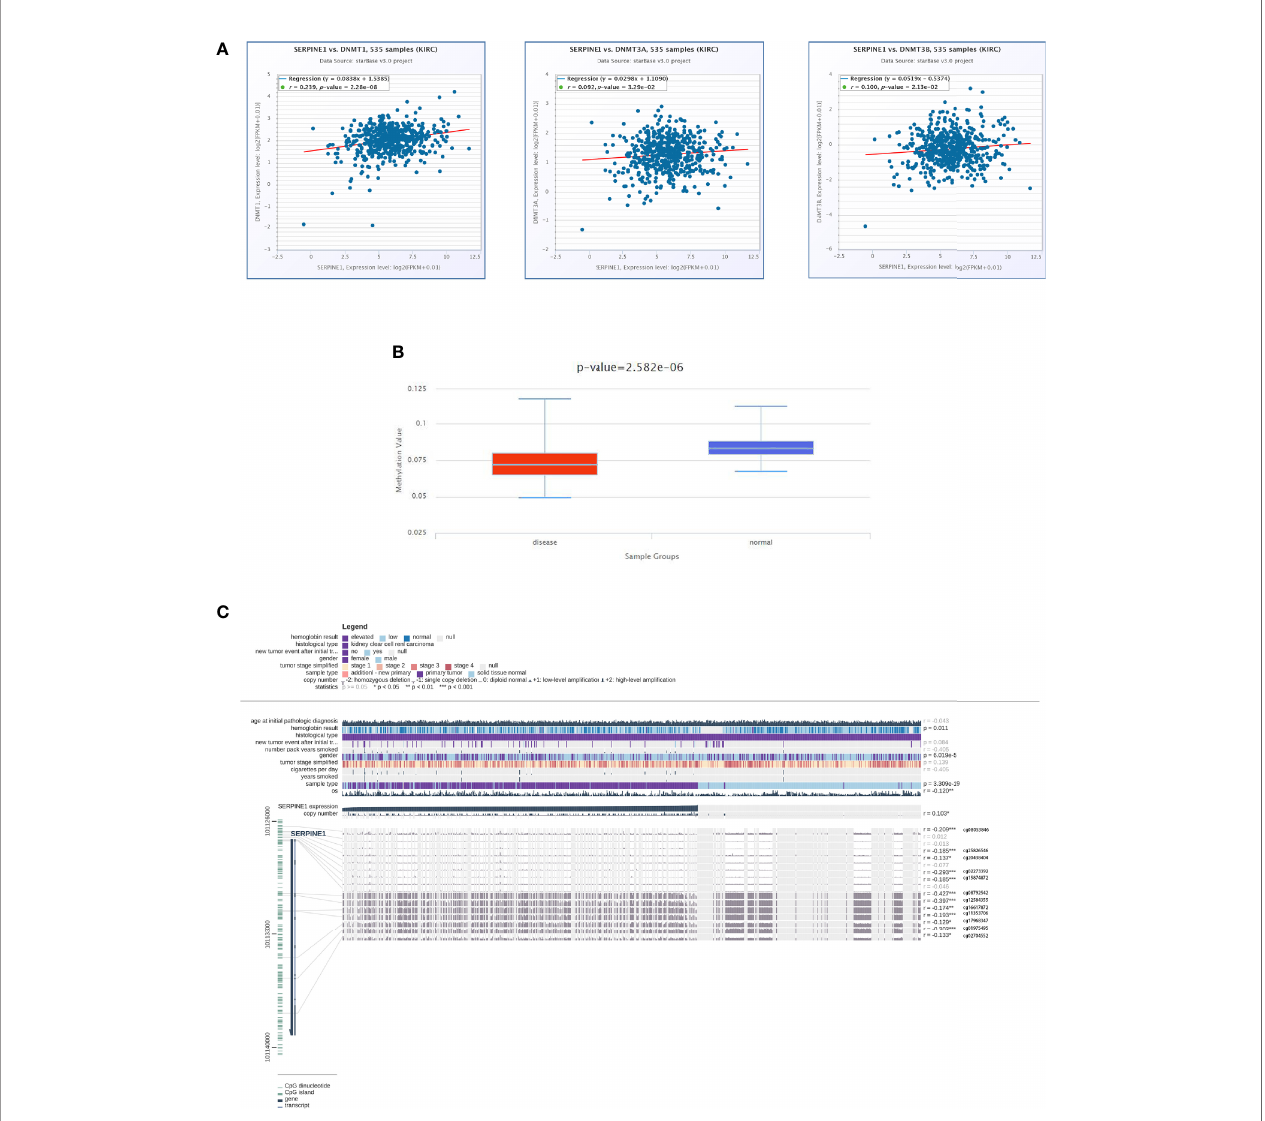
FIGURE 10 | DNA methylation analysis of SERPINE1. (A) Co-expression analysis of SERPINE1 with three DNMTS (DNMT1, DNMT3A and DNMT3B); (B) Methylation level of SERPINE1 comparing KIRC and normal samples; (C) Relationship between SERPINE1 expression and genome-wide methylation by